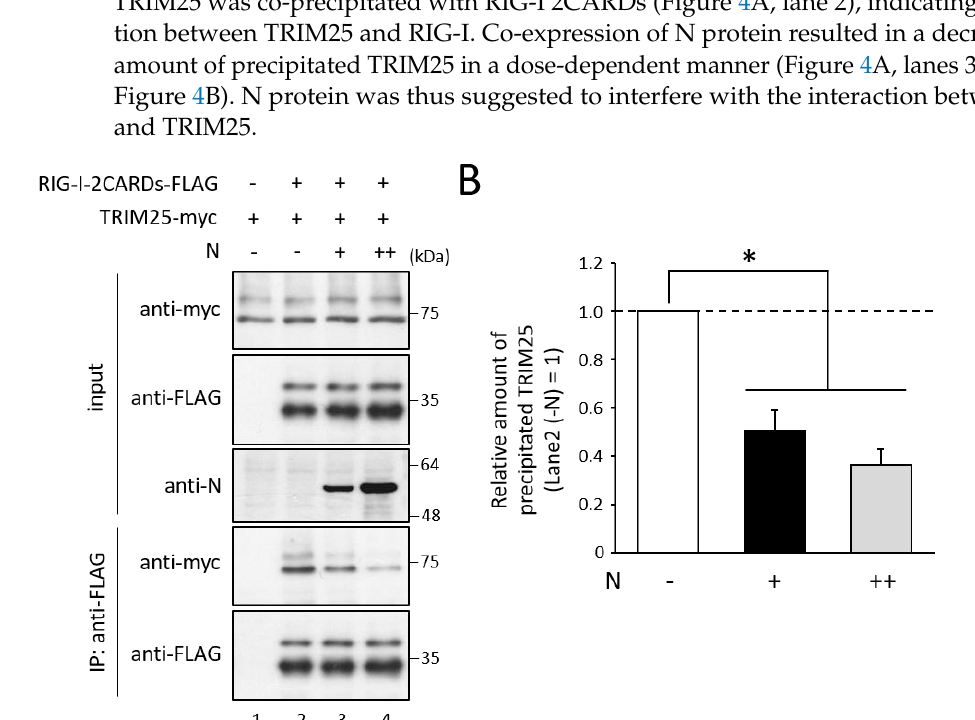
Figure 4. Effects of N protein on the interaction between RIG-I and TRIM25. ( A ) COS cells were transfected with the indicated plasmids. After 48 h, cell lysates were analyzed by immunoblot and immunoprecipitation assays (Figure 2). ( B ) The quantitative densitometry of precipitated TRIM25 in (A) was performed using ImageJ software (http://rsb.info.nih.gov/ij) (accessed on 22 January 2021). Data are the means from three independent experiments, and are shown as the relative value (lane 2 = 1). p values were calculated by the Student’s t -test. *, p < 0.05, compared to values of lane 2. Error bars indicate standard deviations.